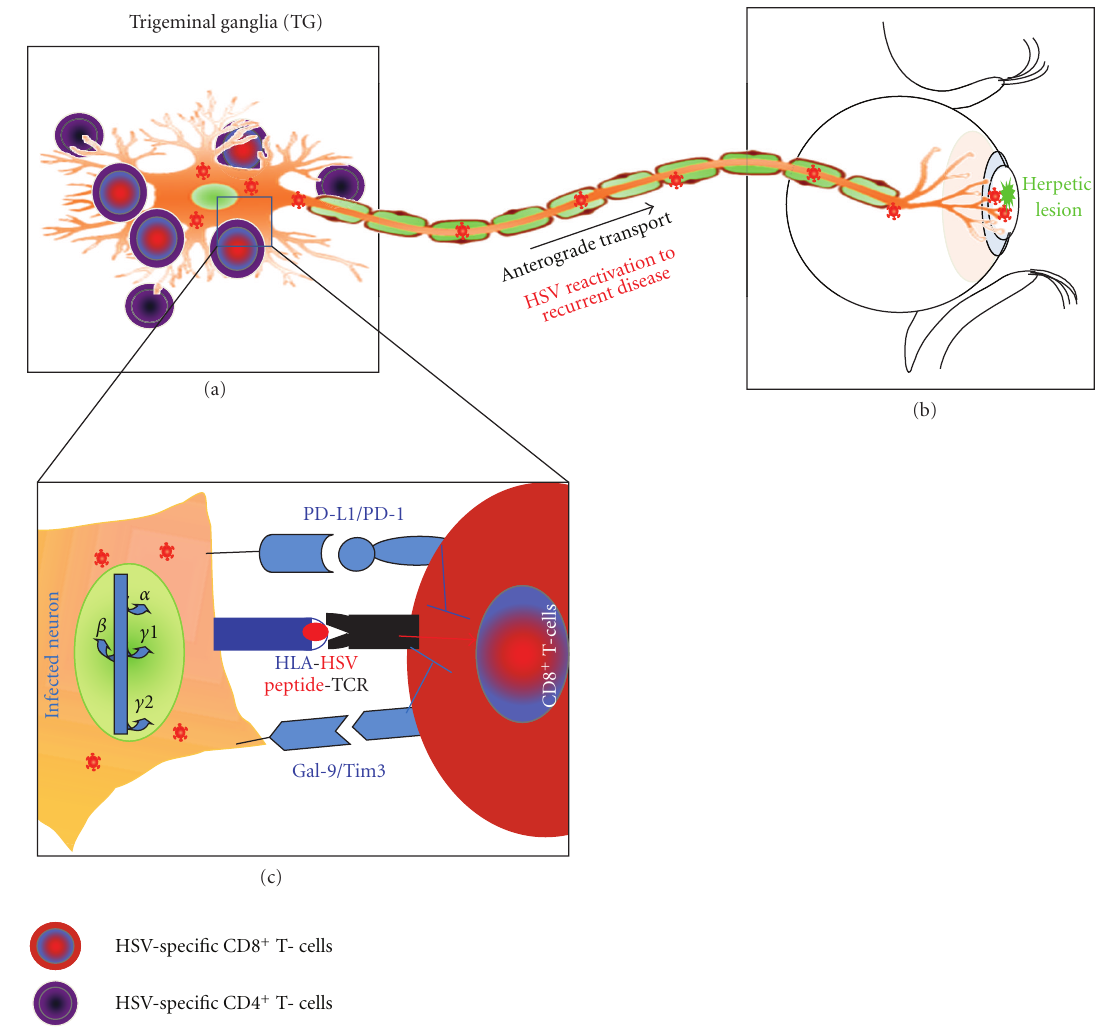
Figure 3: A model of CD8 + T-cell exhaustion and HSV-1 reactivation from sensory ganglia. During reactivation, the virus travels from the TG back to the cornea and causes eruptions of epithelial surfaces (viral shedding). Viral reactivation may be asymptomatic or may be associated with symptoms or lesions [7, 76–79]. This reactivation event may be spontaneous, but it is generally believed to be triggered by stress stimuli and immunosuppressive conditions. CD8+ T-cell function is compromised (e.g., by stress-related hormones), viral glycoproteins and nucleocapsids are formed and transported by anterograde axonal transport, virions are assembled at nerve termini, and infectious virus is released, potentially leading to recurrent disease. Evidence from our laboratory and others suggested that latently infected neurons appear to be resistant to CD8+ T-cell-mediated killing and that LAT is involved in this resistance to CD8+ T-cell killing. Recently, we found that neuroblastoma cells expressing LAT in the absence of other HSV-1 genes resisted to GrB-induced apoptosis and are protected from CD8+ T-cells attack. Also, latently infected TG have high expression of PDL-1 and Gal9 on infected neuronal cells also the majority of CD8+ T-cells surrounding neuronal cells express high PD-1 and